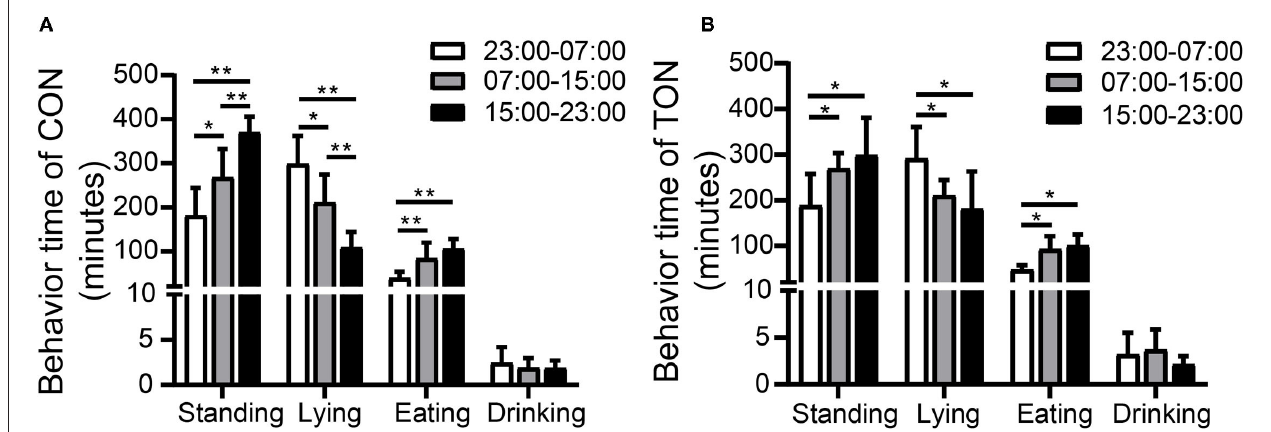
FIGURE 2 | Minutes of activities duration among three periods in TON and CON. (A) Behavior duration of TON cows in three periods in 24h. (B) Behavior duration of CON cows in three periods in 24h. TON, cows with tongue rolling behavior; CON, cows without abnormal behavior. ** P < 0.01; * P < 0.05.